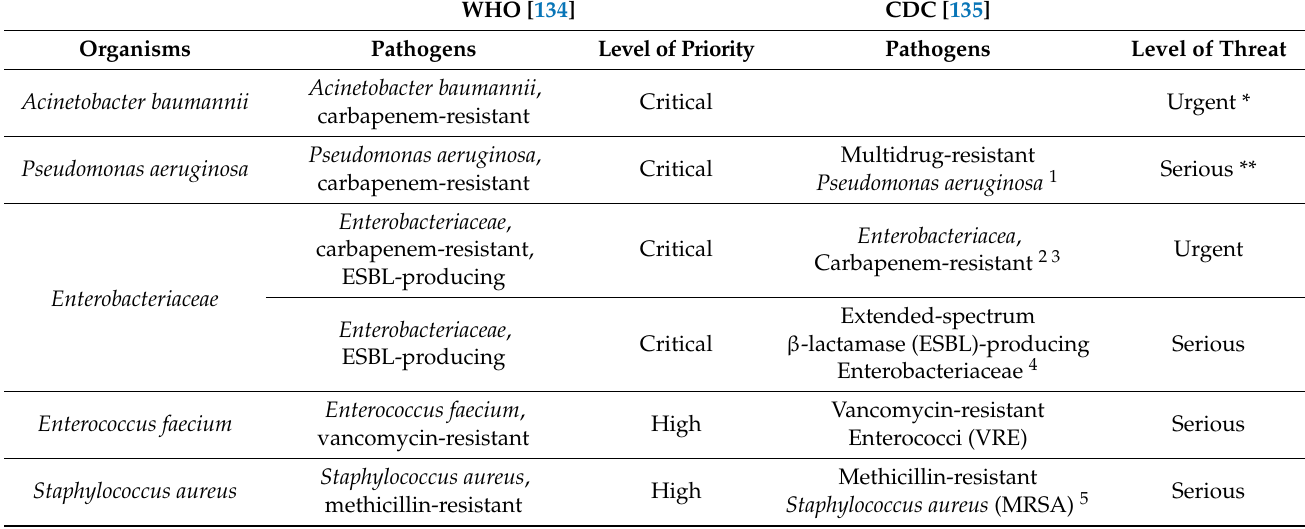
Table 1. The WHO and CDC listing of priority pathogens and the level of threat. WHO